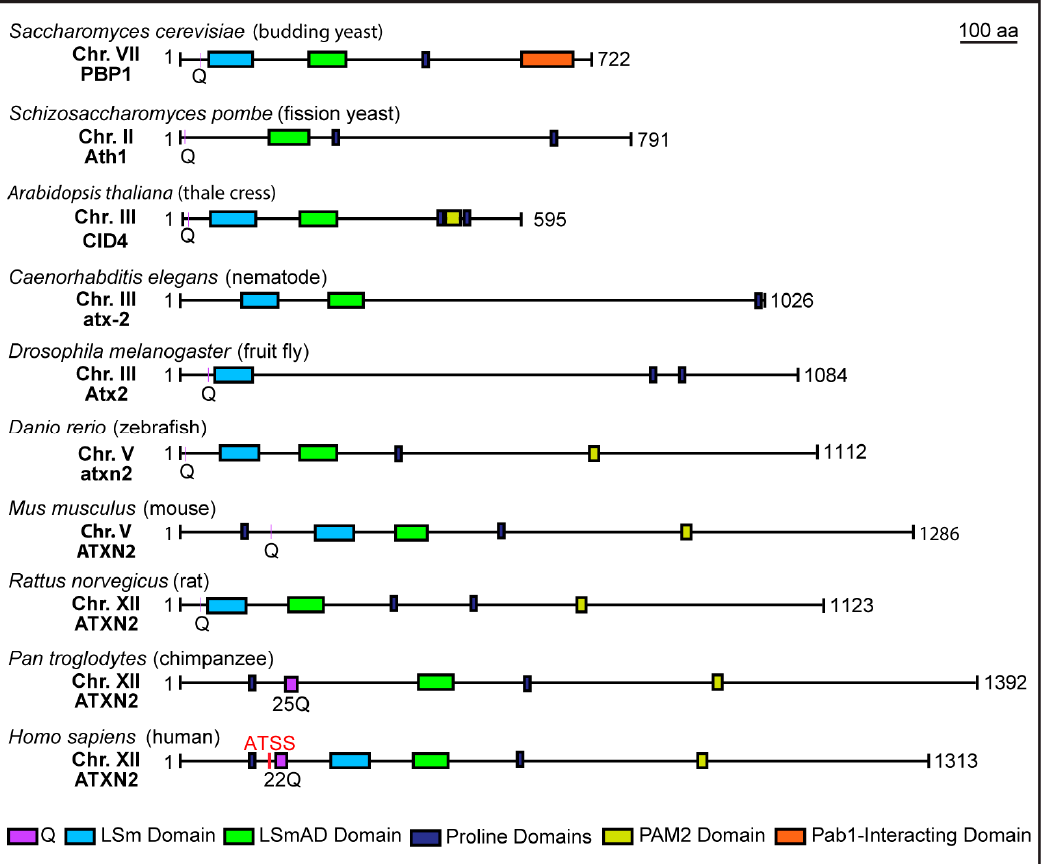
Figure 1. Structure of Ataxin-2 and its conserved domains across model species. The RNA-binding domains of Ataxin-2, Like-Sm (LSm) and LSm-associated (LSmAD), are located at the N-terminal region and are conserved across species. The C-terminal region of Ataxin-2 harbours a PAM2 domain, which interacts with the poly(A)-binding protein (PABP1). A polyglutamine (polyQ) tract is also located in the N-terminal of most mammalian species. For species with multiple Q residues upstream of the LSm/LSmAD domains ( S. pombe , D. rerio , M. musculus ), the Q represented was chosen based on amino acid sequence similarities with the regions flanking the polyQ site in human ATXN2. Conserved proline-rich domains are also depicted (consensus sequences: PPAXPTXXSP and PPSRPSRPPS). ATSS = alternative translational start site.